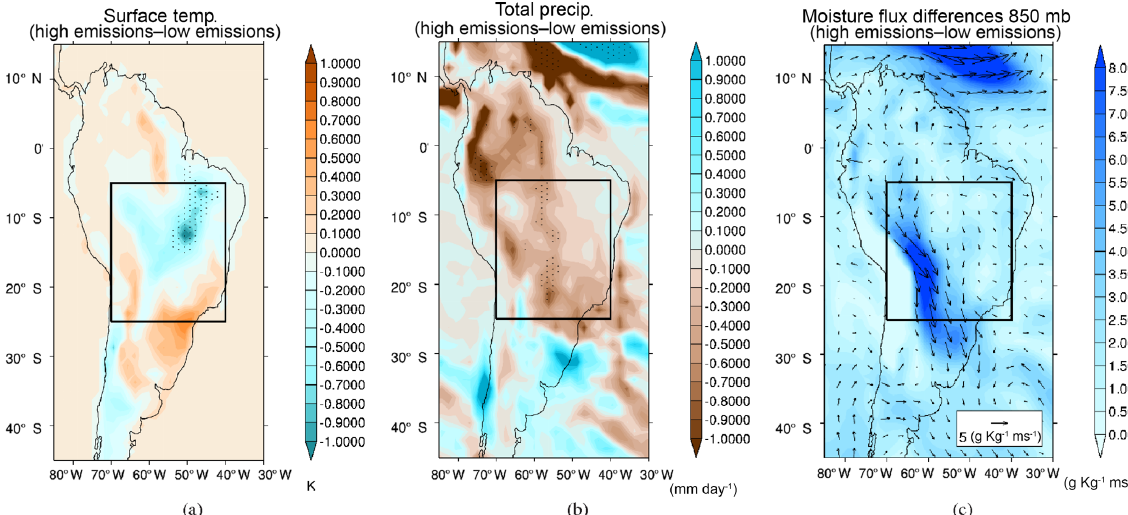
Figure 15. September mean differences (high − low) for (a) surface temperature, (b) total precipitation (stippling represents the 95% confi- dence interval) and (c) moisture flux differences at 850mb; coloured contours are the magnitude of the moisture